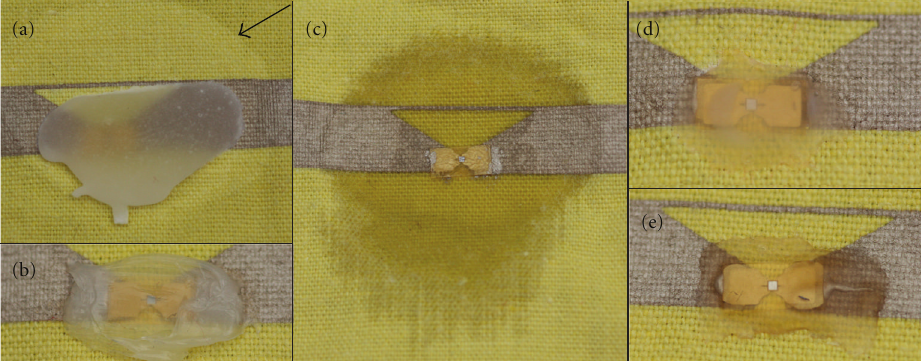
Figure 6: Photographs of the coated ICs on Fabric (A). (a) Acrylic; larger acrylic lump on the backside is visible as a white fabric, indicated with an arrow. This hard piece of acrylic makes the t-matching section hard, which possibly prevented it from breaking in laundry. (b) Silicone. (c) Epoxy. (d) PVA2 glue (PVA1 glue looks similar). (e) Latex